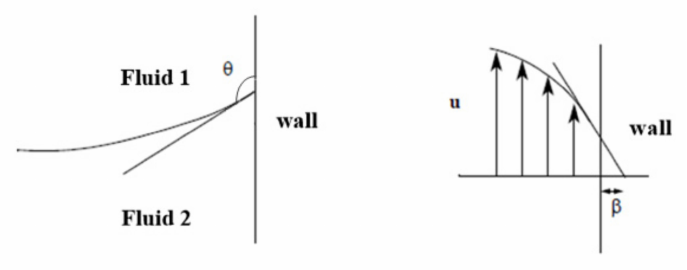
Figure 3. Schematic images showing contact angle θ and slip length β used for this